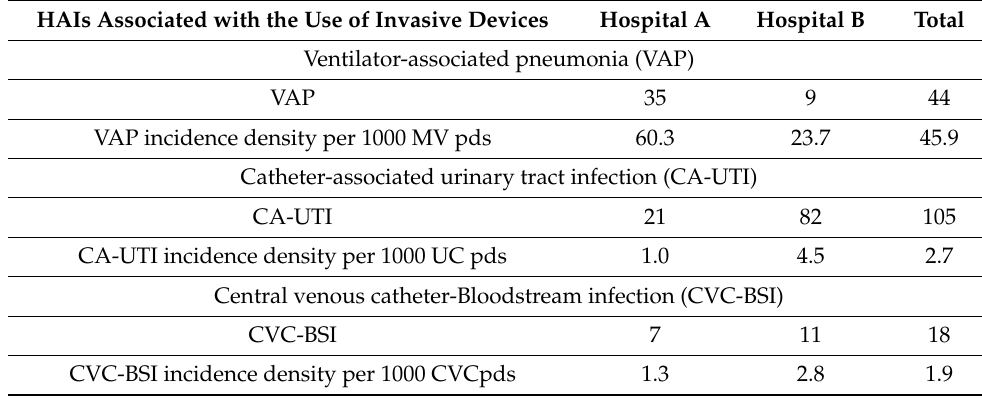
Table 3. Analysis of device-associated PN, UTI, BSI in neurosurgery units in the years 2014–2019. HAIs Associated with the Use of Invasive